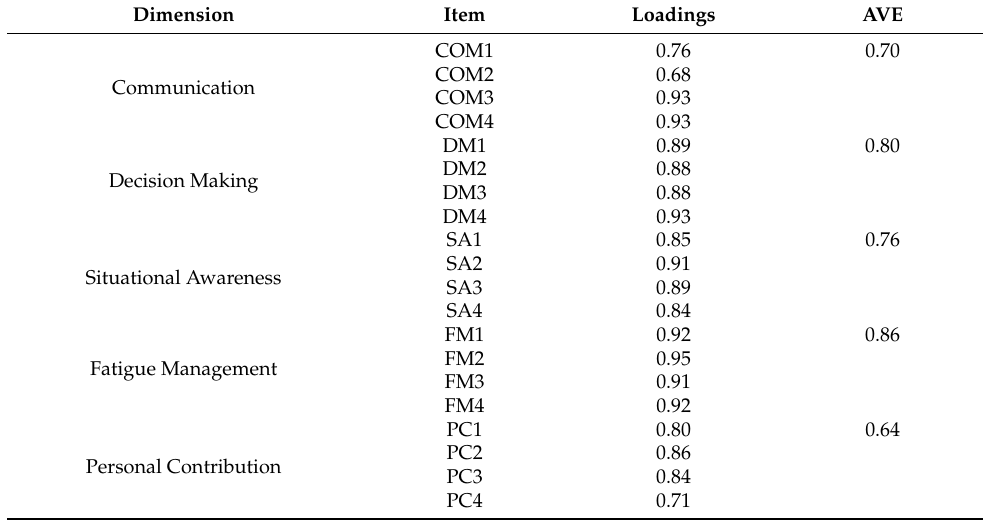
Table 4. SAPH@W CFA model on Sample-B ( n = 543): factor loadings and AVE.